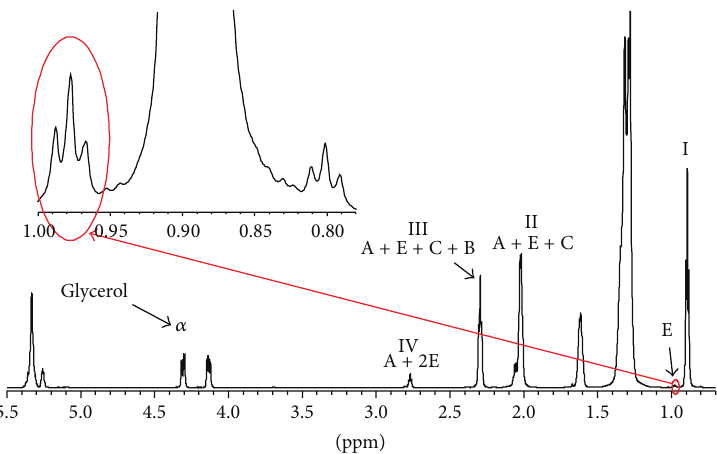
Figure 1: Typical proton NMR spectrum of eVOOs with highlighted the characteristic peaks of fatty acids and glycerol moieties used for the determination of fat percentage. In addition, the expansion shows the 13 C satellites of the methyl peak at 0.85 ppm (I) superimposed to that of linolenic at 0.98 ppm